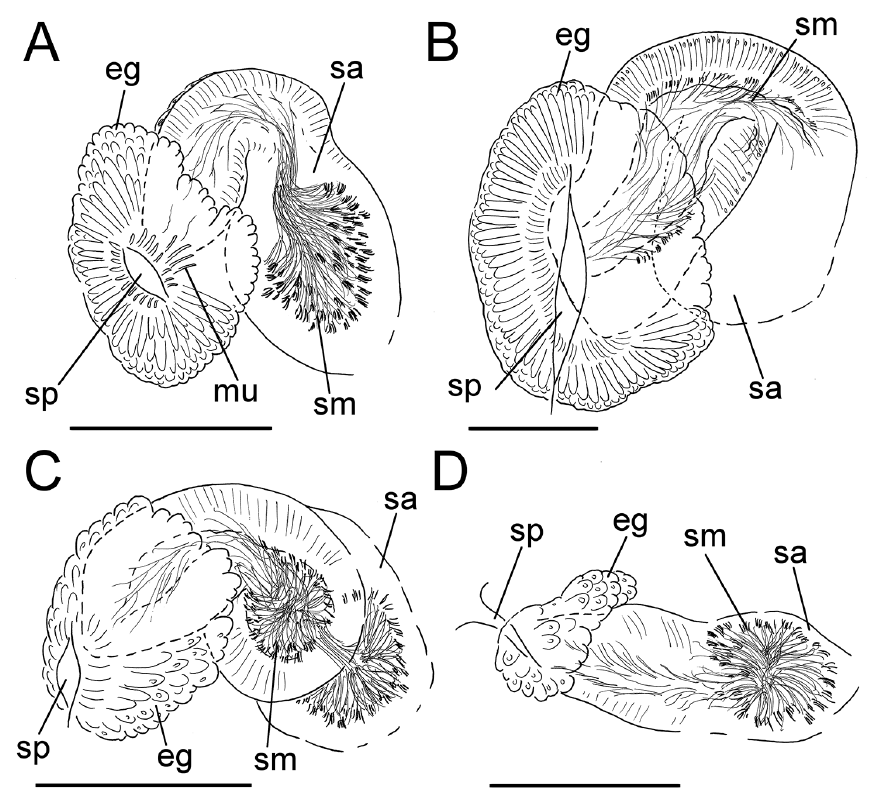
Figure 3. A Lumbricillus lineatus , spermatheca B Lumbricillus latithecatus sp. n. (holotype), sper- mathecae C Lumbricillus verrucosus , spermatheca D Lumbricillus verrucosus , spermatheca seen from below. Scale bars: 100